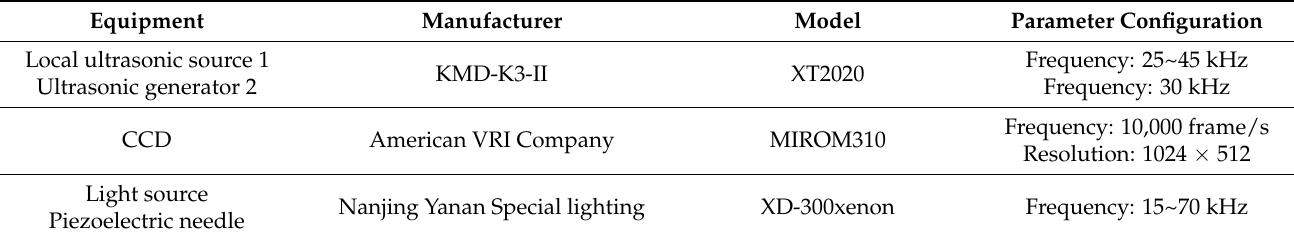
( b ) Figure 11. Experimental subject ( a ) Experimental water droplet and related parameters, ( b ) Experi- mental Ga-In alloy droplet. First, taking pure water as an example, the water droplet has a density of ρ = 1.0 g/cm 3 , surface tension coefficient of σ = 7.60 × 10 −2 N/m 3 , viscosity coefficient of µ = 1.00 ×